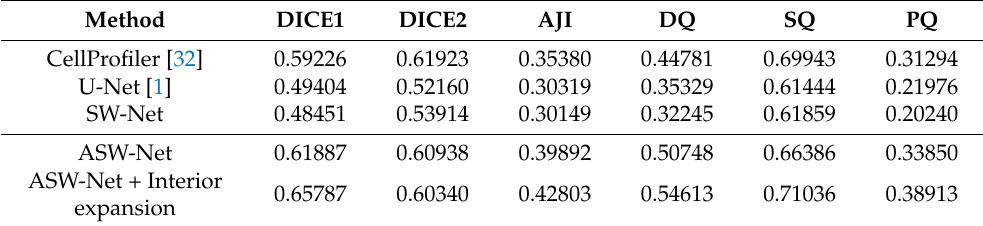
Table 3. The performance comparison on low SNR ganglioneuroblastoma dataset.